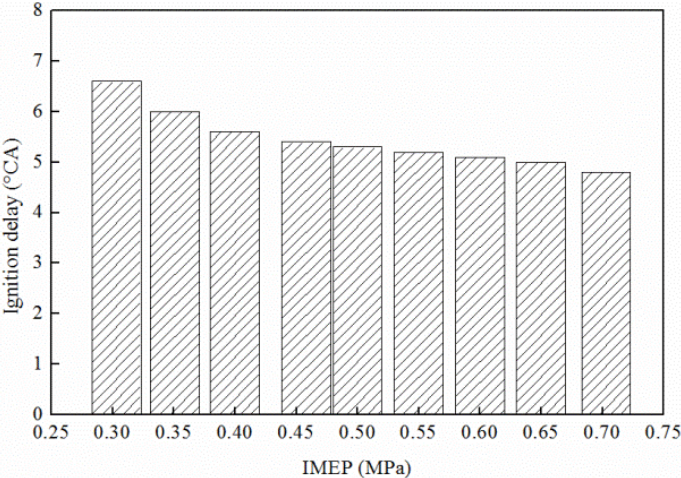
Figure 6. ID at different loads.